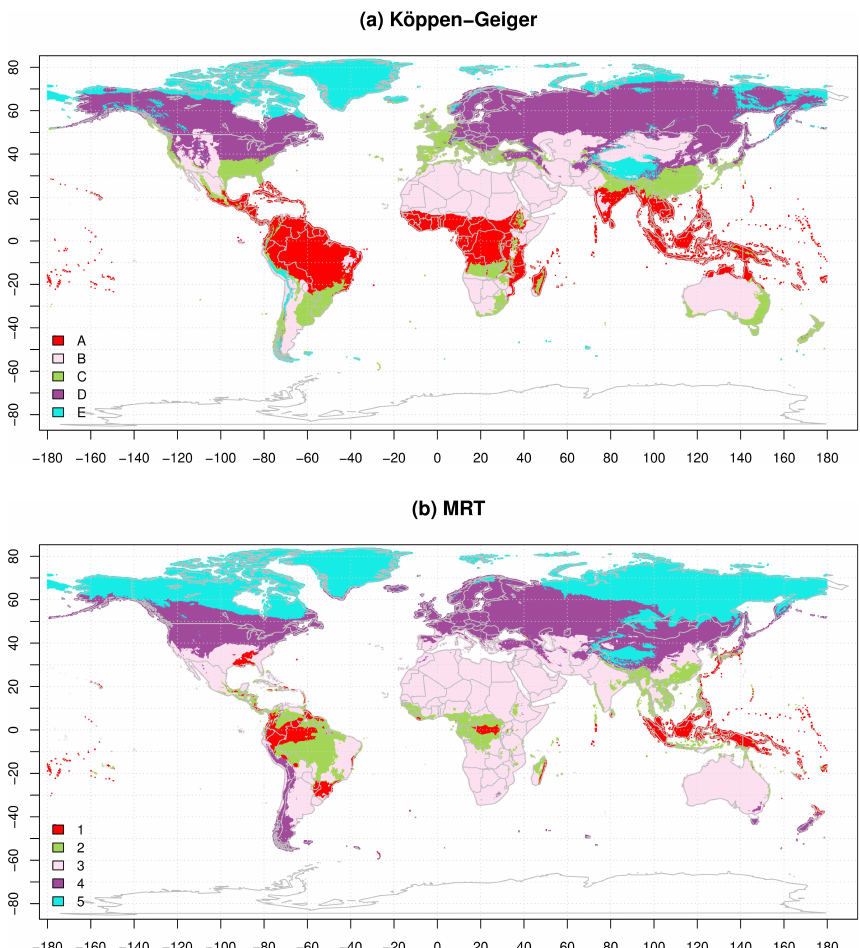
Fig. 5. Global maps of (a) K¨oppen-Geiger and (b) MRT climate classifications at the 5 class